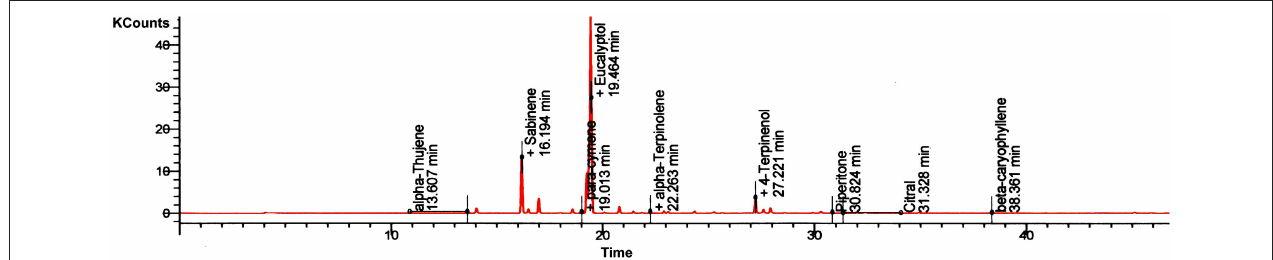
FIGURE 1 | Gas chromatography-Mass Spectrometery chromatogram of the essential oil of Z. armatum DC. The y-axis shows peak counts in thousand (K counts), while the x-axis shows retention time in minutes. Standard chromatogram showed presence of important EO constituents’ alpha-thujene (13.607min), sabinene (16.194min), eucalyptol (19.464min), alpha-terpinolene (22.263min), 4-terpinenol (27.221min), piperitone (30.824min), citral (31.328min), and beta-caryophyllene (38.361min). Besides, these significant peaks, small peaks were also recorded but not shown in the chromatogram.